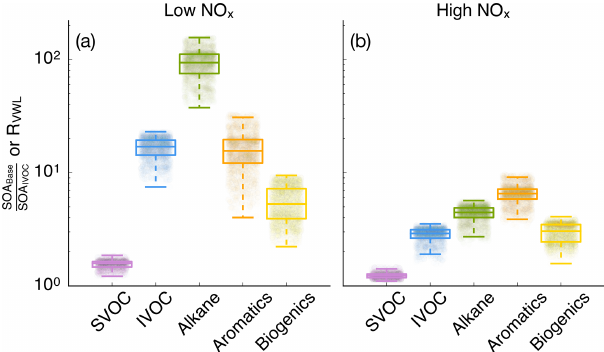
Figure 4. Ratio of model predictions from the Base simulation that accounts for the influence of vapor wall losses to model predictions from the IVOC simulation that does not account for the influence of vapor wall losses. Ratios are calculated from the 14-day-averaged results for the whole domain and are resolved by precursor. Panels (a) and (b) show results from the low- and high-NO x simulations